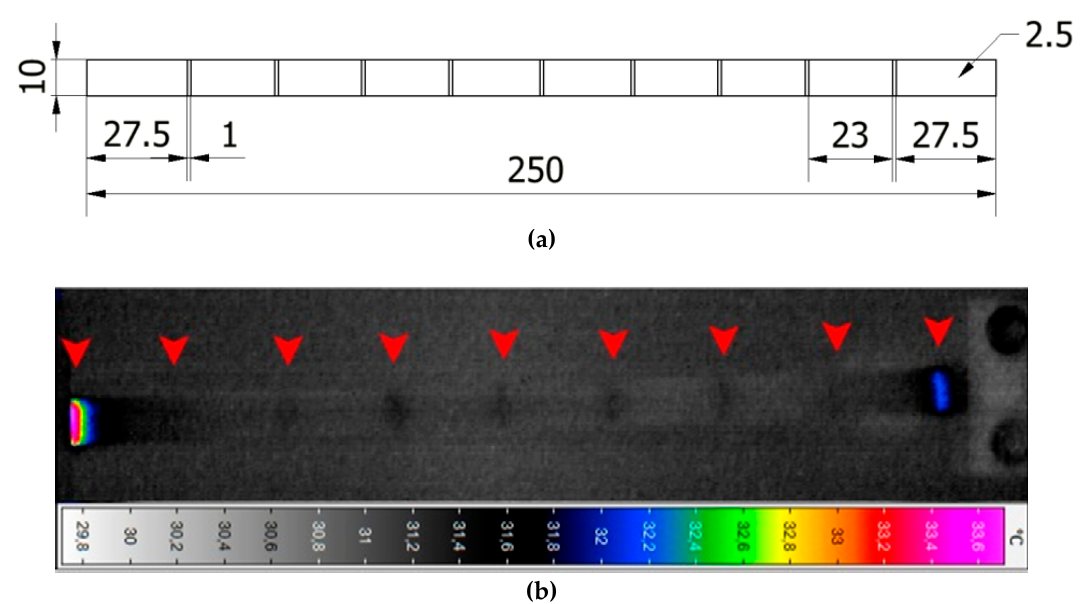
Figure 22. Exemplary results of damage identification by using the SHVT method: ( a ) scheme of the introduced damage; ( b ) thermal response of a PMC structure.